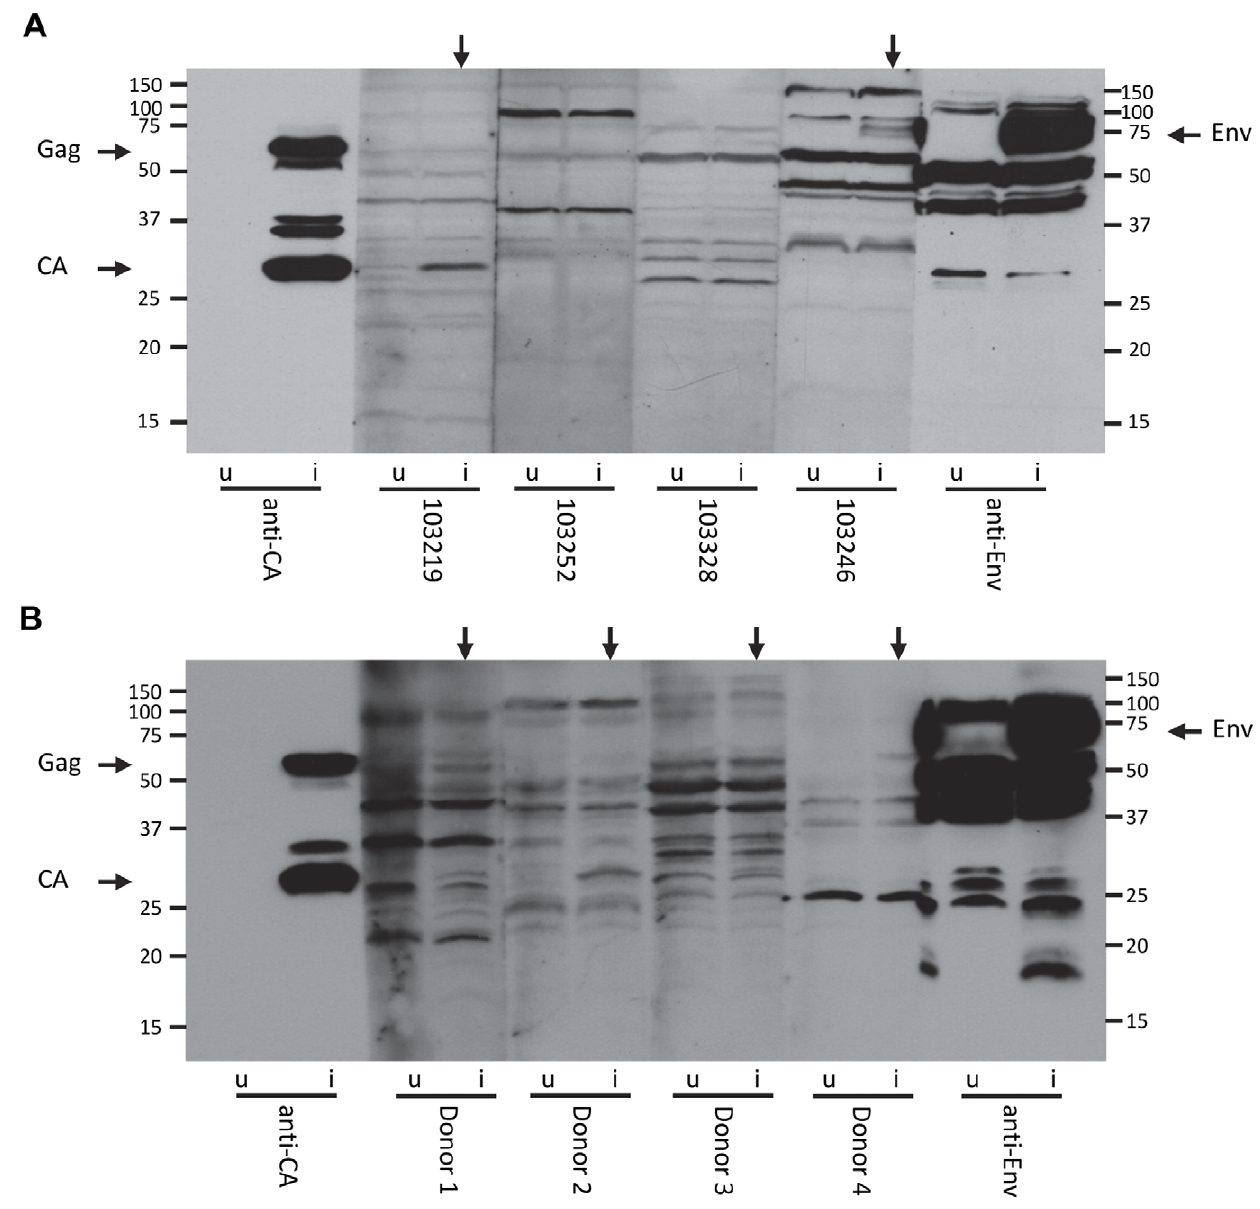
Figure 4. XMRV-reactive antibodies in patient and healthy blood donor sera. Representative Western blots using uninfected (u) and XMRV- infected (i) LNCaP cell lysate as antigen for (A) HIV-1 infected patient sera or (B) healthy blood donor sera, and positive-control antibodies against p30 capsid (anti-CA) and gp70 SU (anti-Env). (A) Vertical arrows indicate lanes in which patient sera displayed reactivity to either XMRV capsid (left arrow, 103219) or XMRV envelope (right arrow, 103246). (B) Vertical arrows indicate lanes in which blood donor sera displayed reactivity to XMRV capsid (all four donors on the blot shown). Protein mobilities are indicated in kiloDaltons.